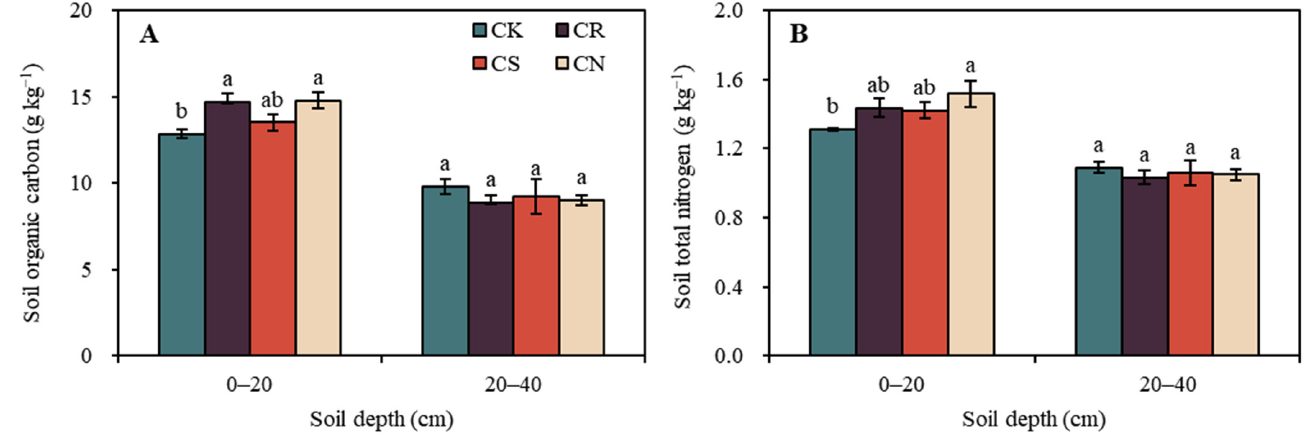
Figure 8. Soil organic carbon content ( A ) and soil total nitrogen content ( B ) at the 0–20 cm and 20–40 cm soil depths as affected by tillage regimes in 2021. CK, rotary tillage without straw returning; CR, rotary tillage with straw incorporation; CS, subsoiling tillage with straw mulching; CN, no tillage with straw mulching. Bar means the standard error. Different letters among the treatments for each soil aggregate fraction indicate a significant difference at p < 0.05.